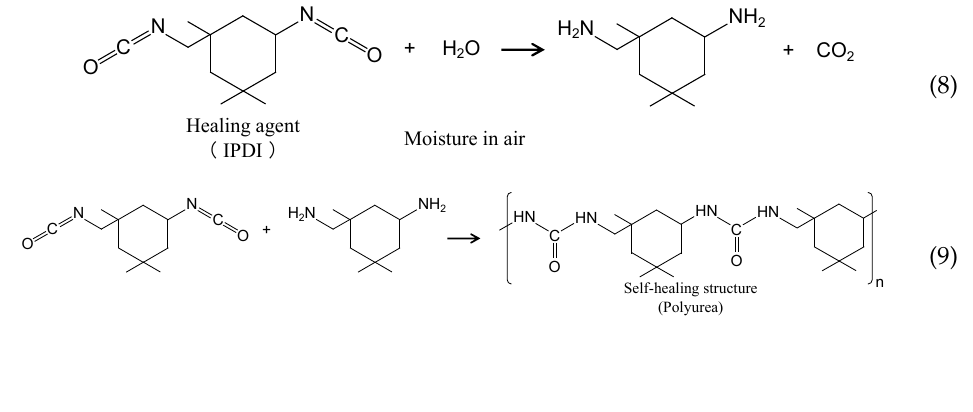
Figure 8. SEM images of the damaged specimen surface covered with a coating ( a ) with no capsule